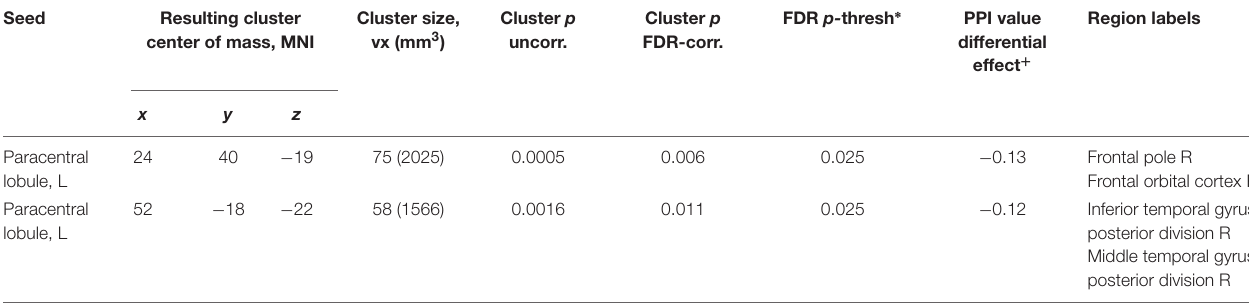
TABLE 6 | Connectivity of the paracentral lobule.